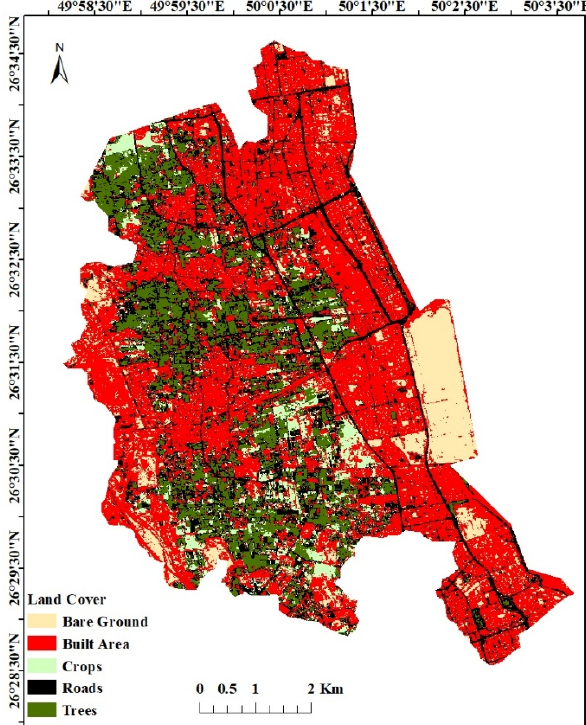
Figure 2. Land use and land cover map of Al-Qatif area.